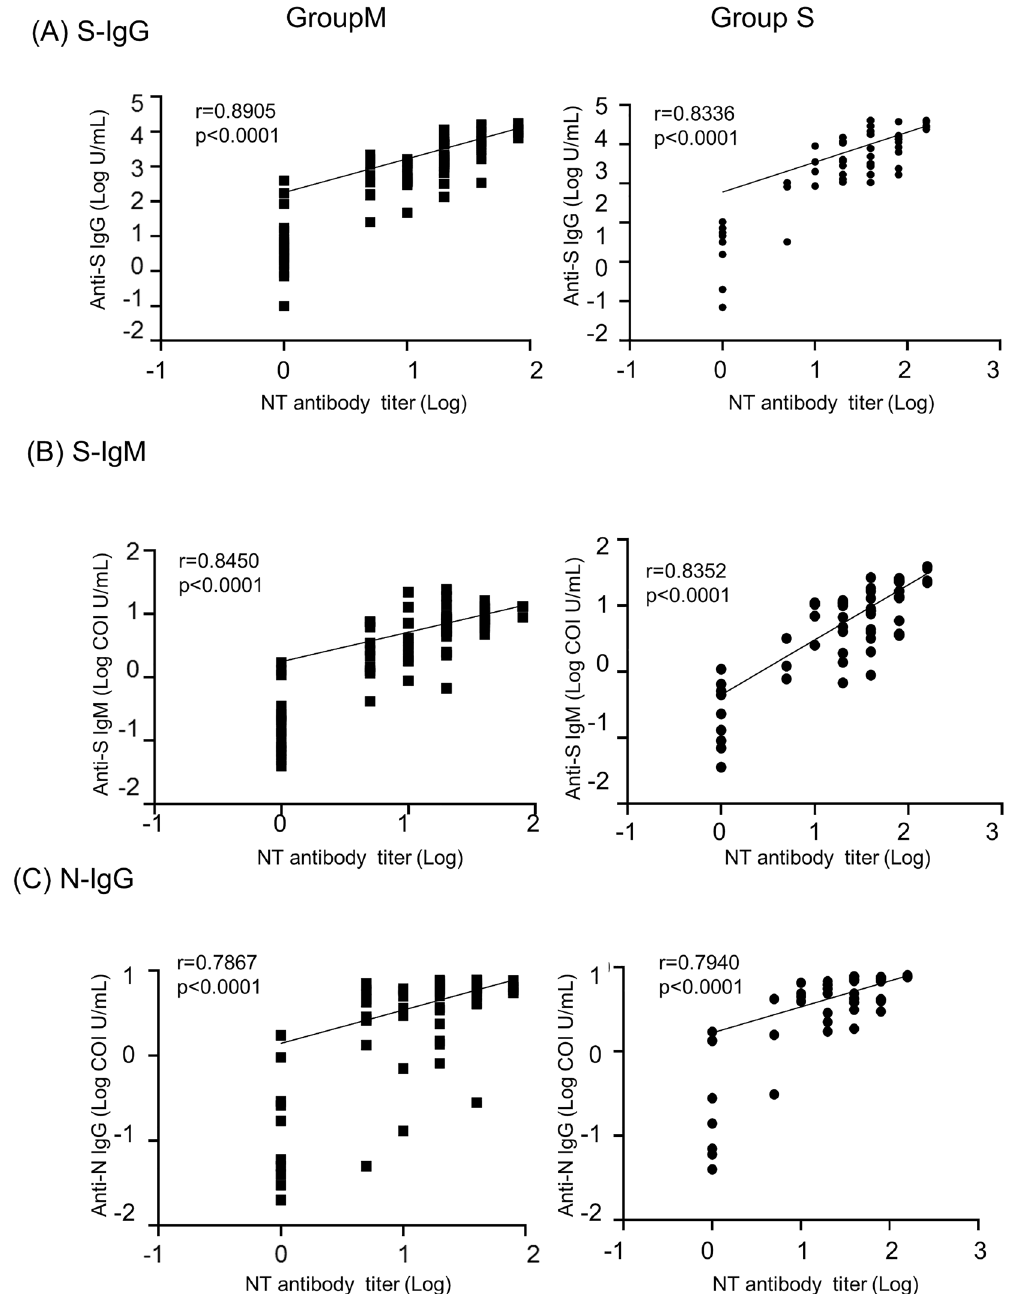
Figure 1. Correlations of S-IgG, S-IgM, and N-IgG assays results to NT antibody assay. ( A ) Correlation of S-IgG (anti-S SARS-CoV-2 IgG II Quant assay) and NT antibody. ( B ) Correlation of S-IgM (anti-S SARS-CoV-2 IgM assay) and NT antibody. ( C ) Correlation of N-IgG (anti-N SARS-CoV-2 IgG assay) and NT antibody. The horizontal axis and the vertical axis are logarithmic notations. One hundred forty-one samples were measured for S-IgG, S-IgM, N-IgG, and NT antibody titers and their correlations were analyzed. Black squares are Group M samples (n = 80 from 43 patients) and black circles are Group S samples (n = 61 from 14